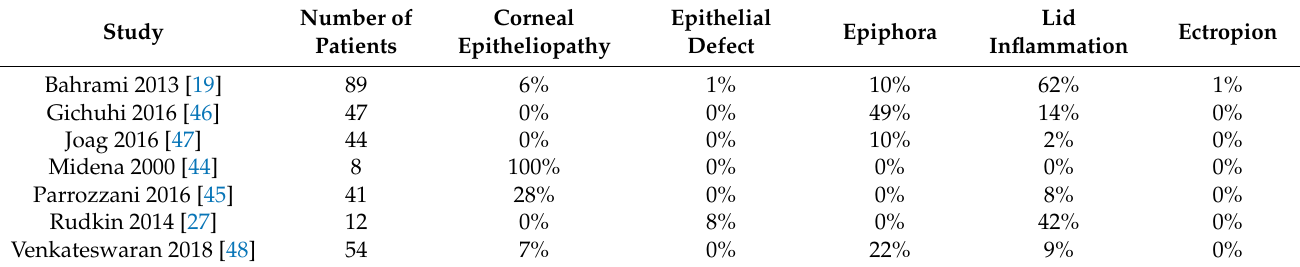
Table 2. Ocular surface complications of 5-fluorouracil for ocular surface squamous neoplasia. Number of Corneal Study Patients